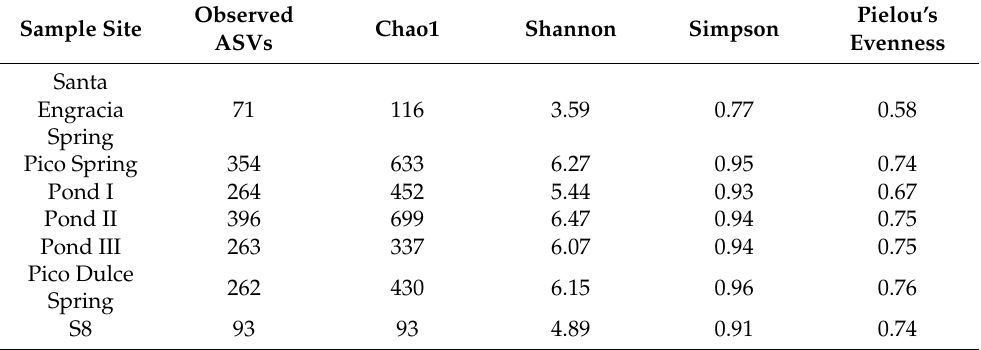
Table 1. Alpha diversity indexes calculated for the locations of the saltern analyzed in the study.